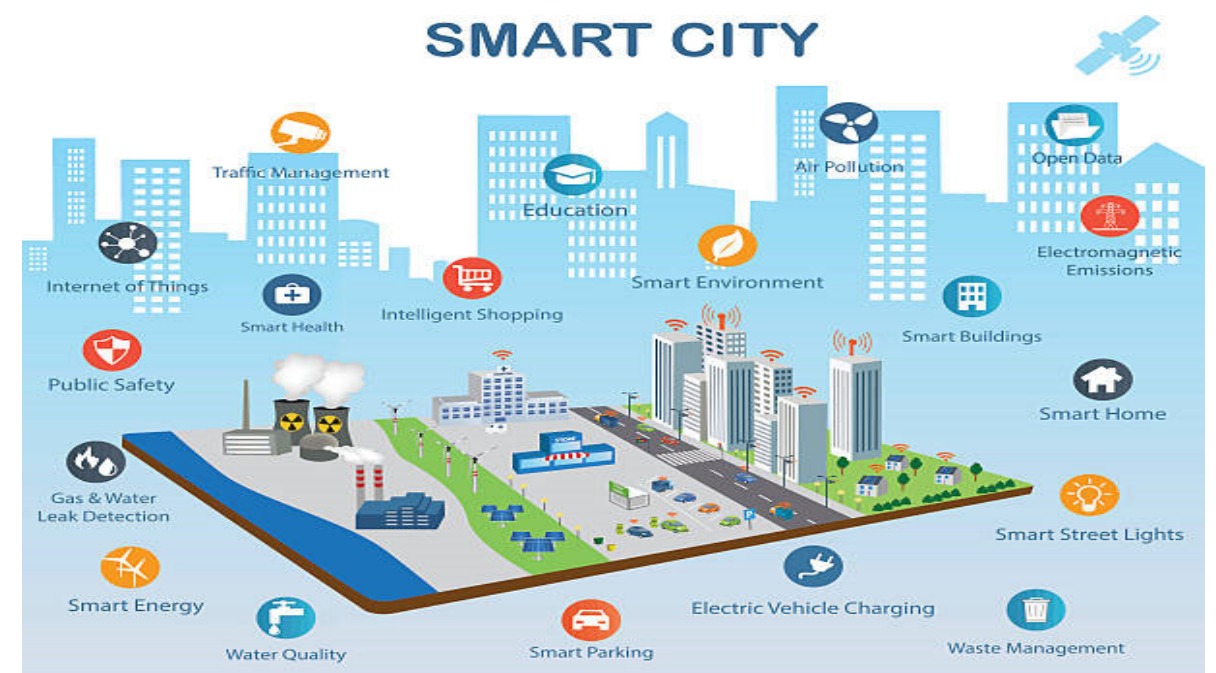
Figure 1. Smart city applications [1].